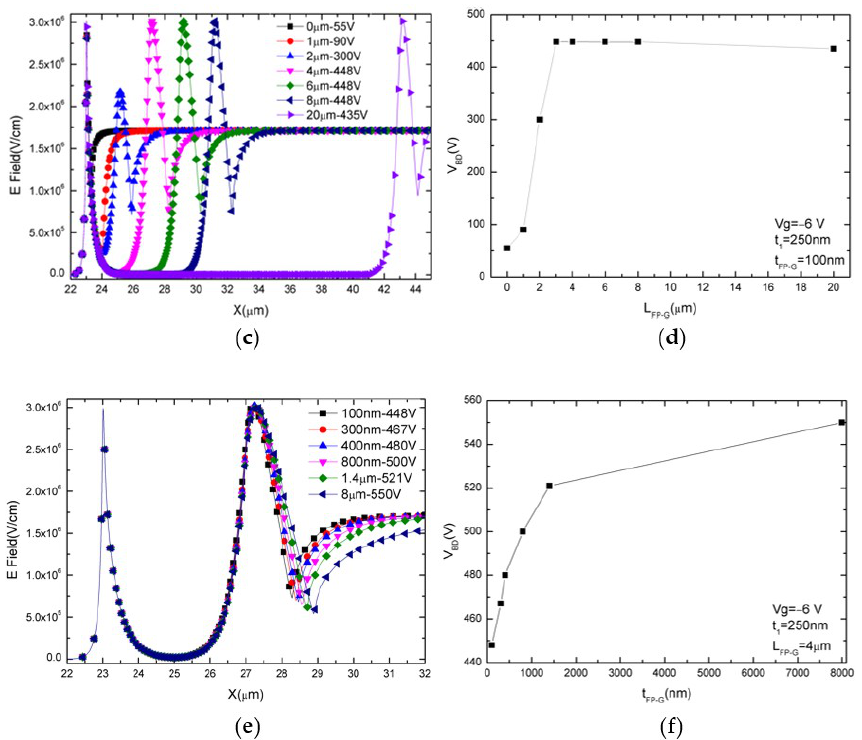
Figure 3. The electric field distributions along the channel for different values of ( a ) t 1 , ( c ) L FP-G , and ( e ) t FP-G . The V BD for different values of ( b ) t 1 , ( d ) L FP-G , and ( f ) t FP-G .